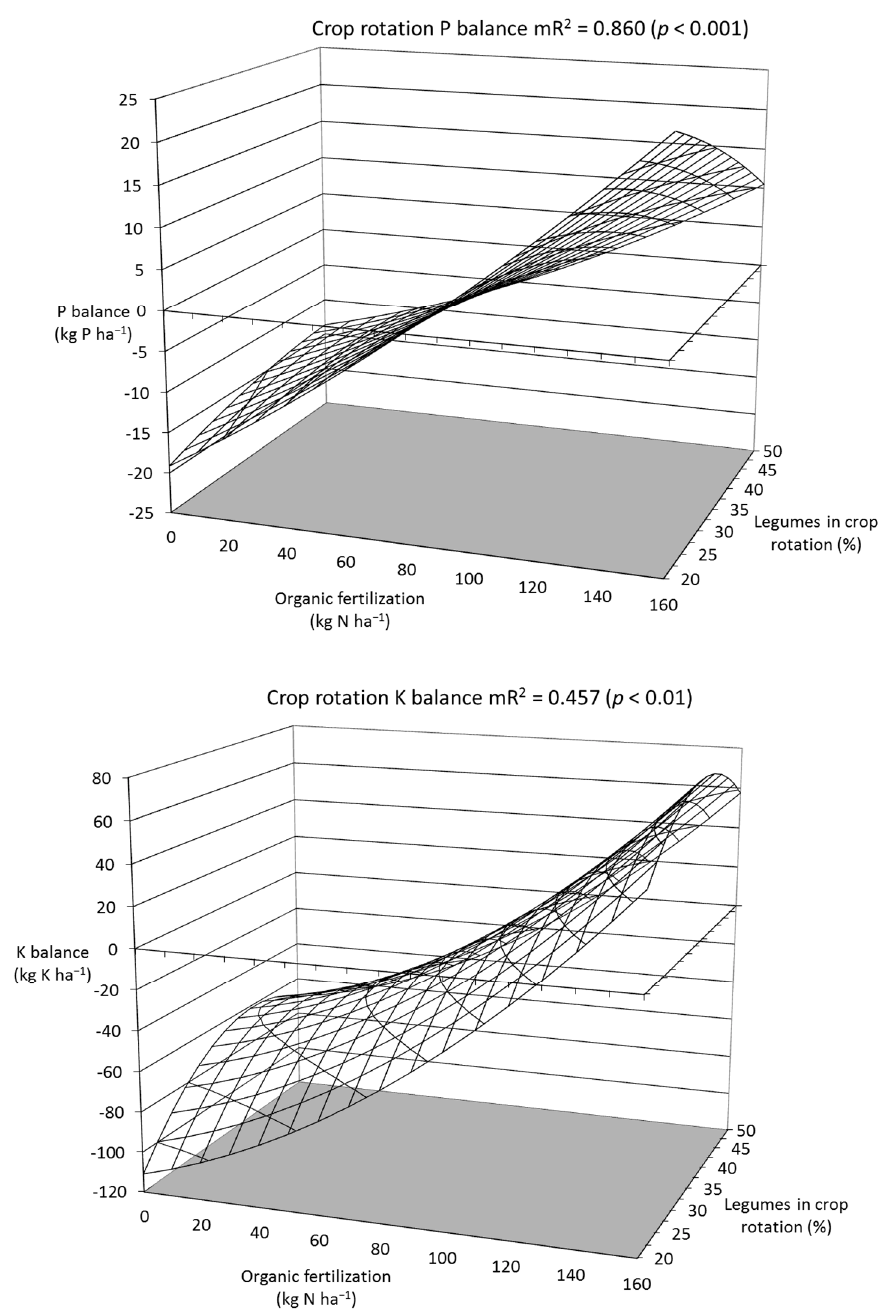
Figure 10. Effects of increasing organic N fertilization and legume proportions in crop rotations on P balances ( above ) and K balances ( below ) of crop rotations on heavy soils.